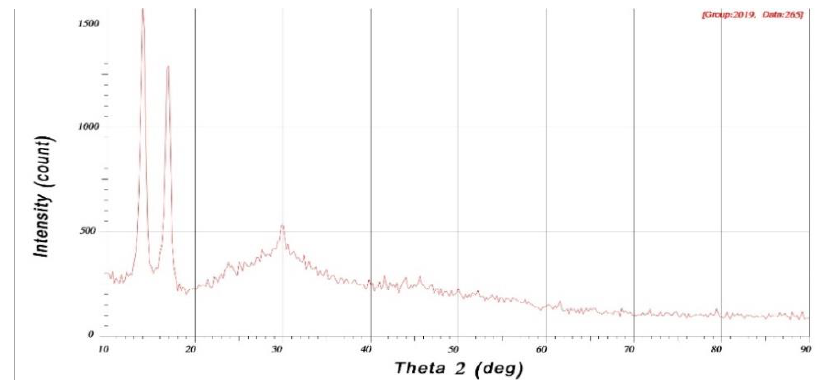
Figure 4. X-ray diffraction pattern for selenium nanoparticles made from sodium selenite with black currant extract in PH 9